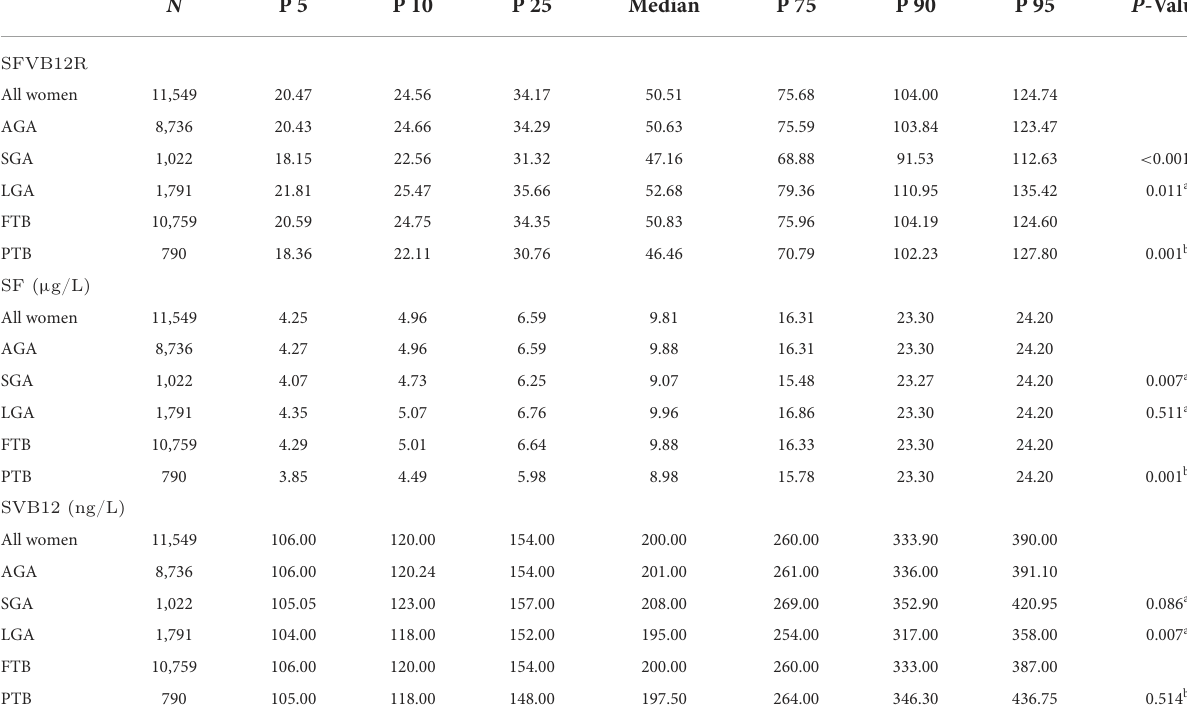
TABLE 4 The distribution of maternal serum levels of folate, vitamin B12, and their ratio on admission for labor according to birth